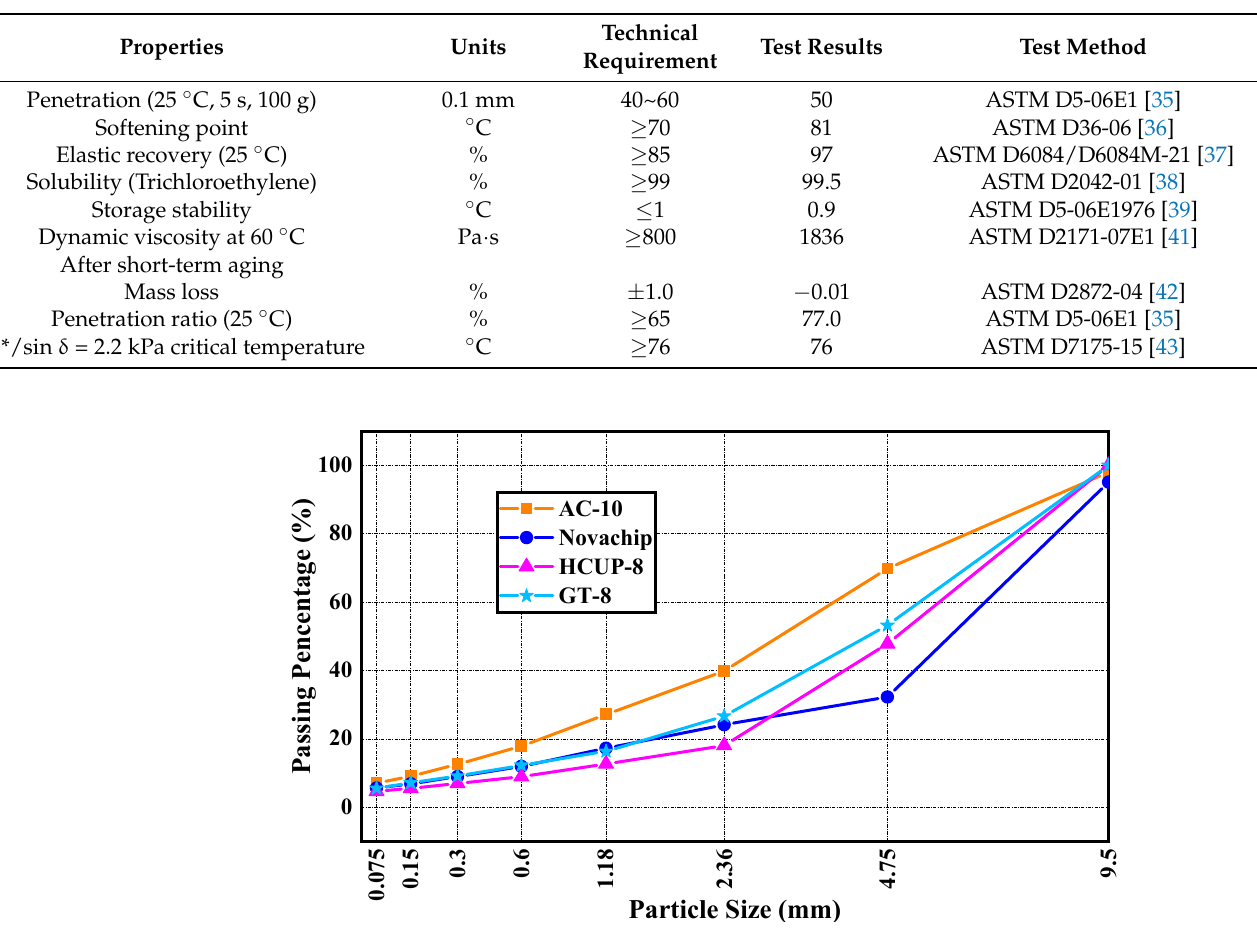
( c ) Figure 2. Standardized performance tests: ( a ) Marshall stability test; ( b ) tensile strength test; ( c ) dynamic stability test.